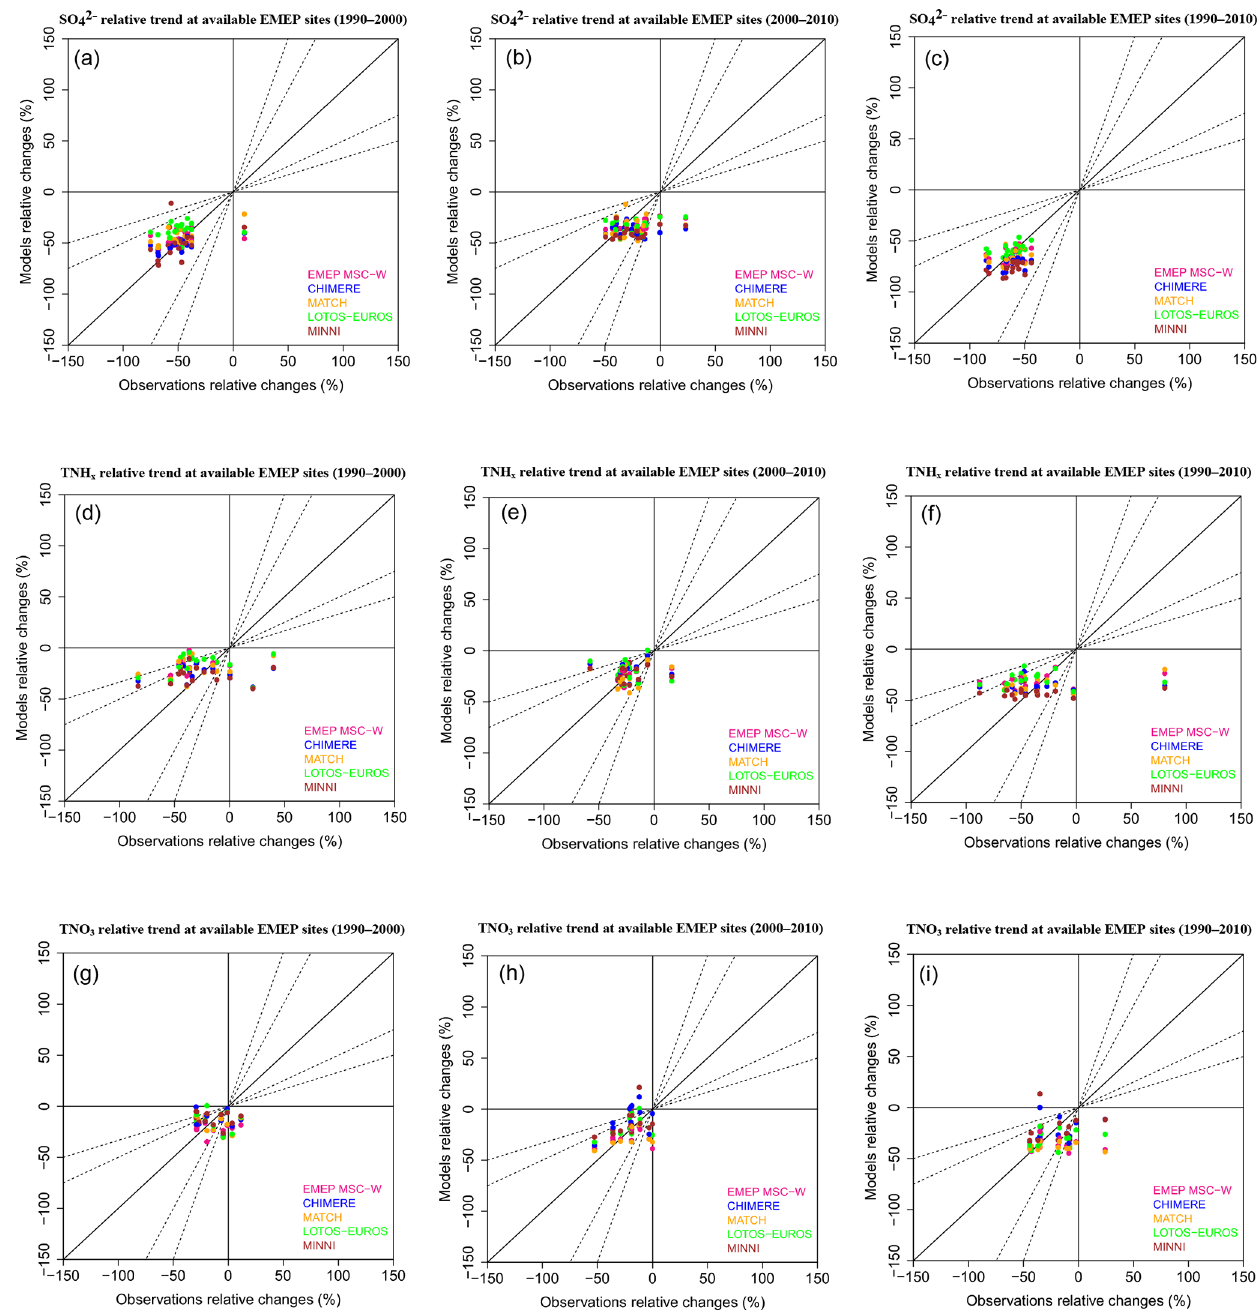
Figure 7. Modeled and observed SO 2 − (a–c) , TNH x (d–f) and TNO 3 (g–i) relative trends for the P1 (1990–2000), P2 (2000–2010) and PT 4 (1990–2010) periods (left to right). The continuous line indicates the 1:1 line, and the dotted lines indicate the 1:2 and 1:3 lines (and their